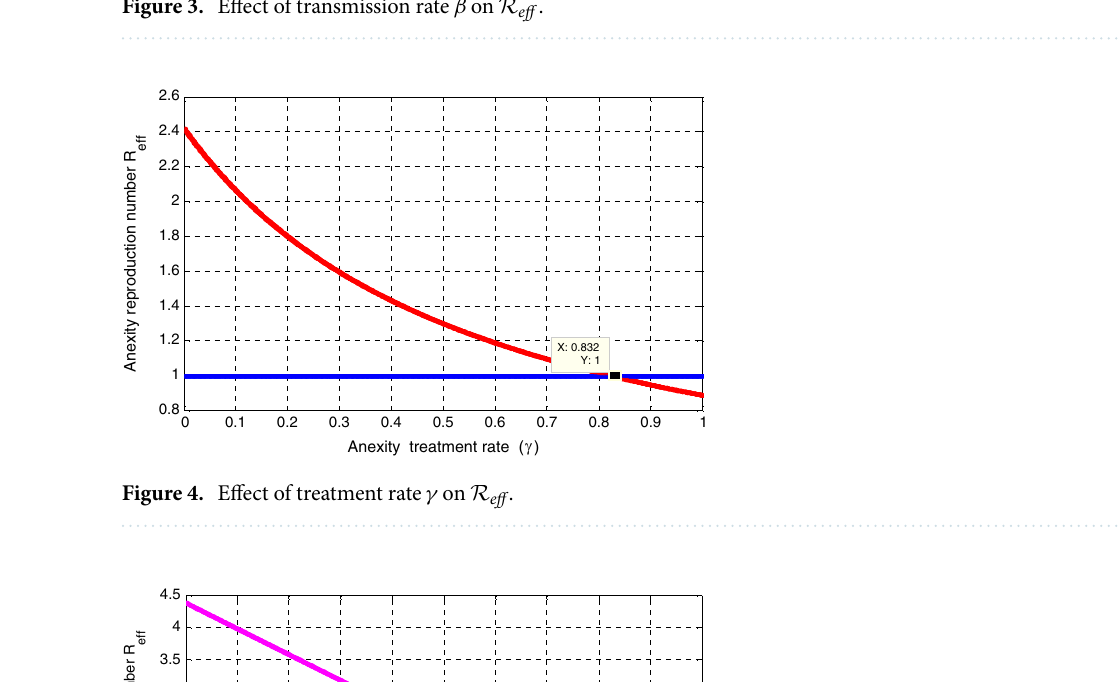
Figure 3. Effect of transmission rate β on R eff .